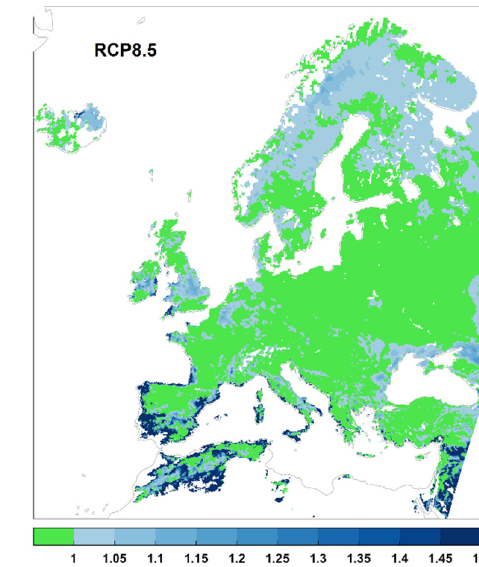
Figure 7. FC envelope maps for characteristic ground snow loads according to the RCP4.5 ( a ) and RCP8.5 ( b ). For each cell of the EUR-11 domain, the maximum value of FC in the moving time windows is shown.